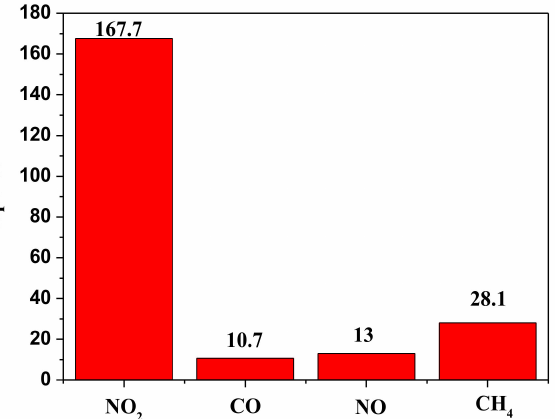
Figure 6. Selectivity test of the 3wt.% Pt/BiVO 4 nanocomposites to 100 ppm of various gases at room temperature.